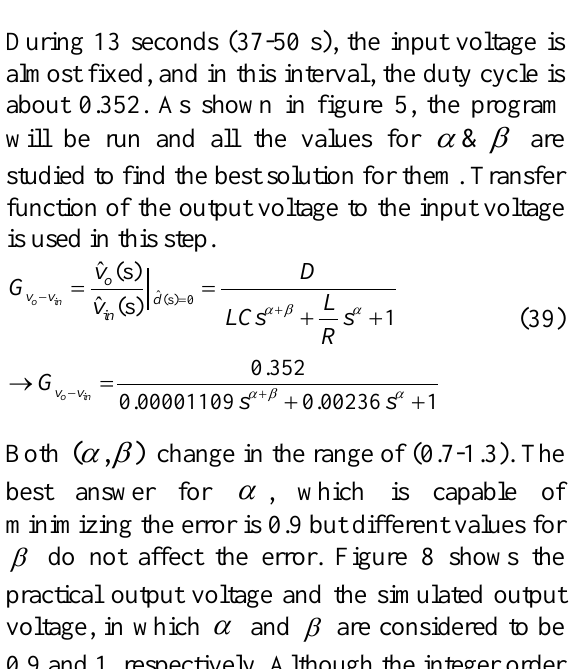
Figure 7. Input voltage of Buck converter gathered by